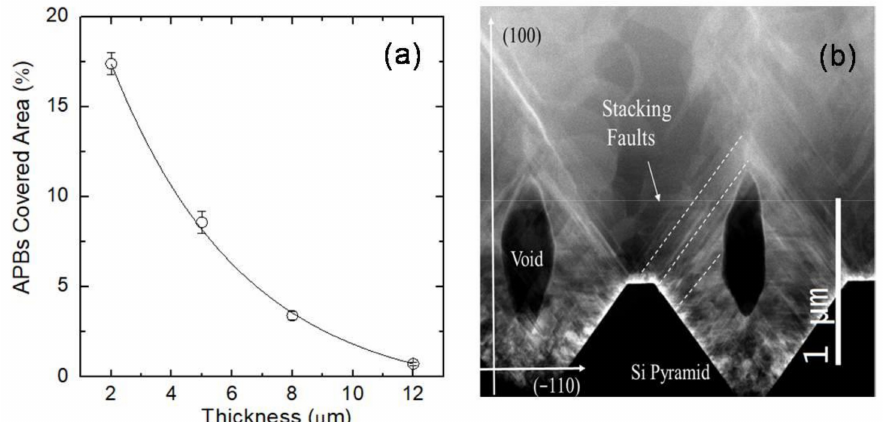
Figure 9. ( a ) Anti-phase boundaries (APBs) covered-area percentages for different thicknesses of the epitaxial growth. ( b ) Cross-section SEM image of 12 um-thick epitaxial 3C-SiC layer grown on ISP (adapted from Reference